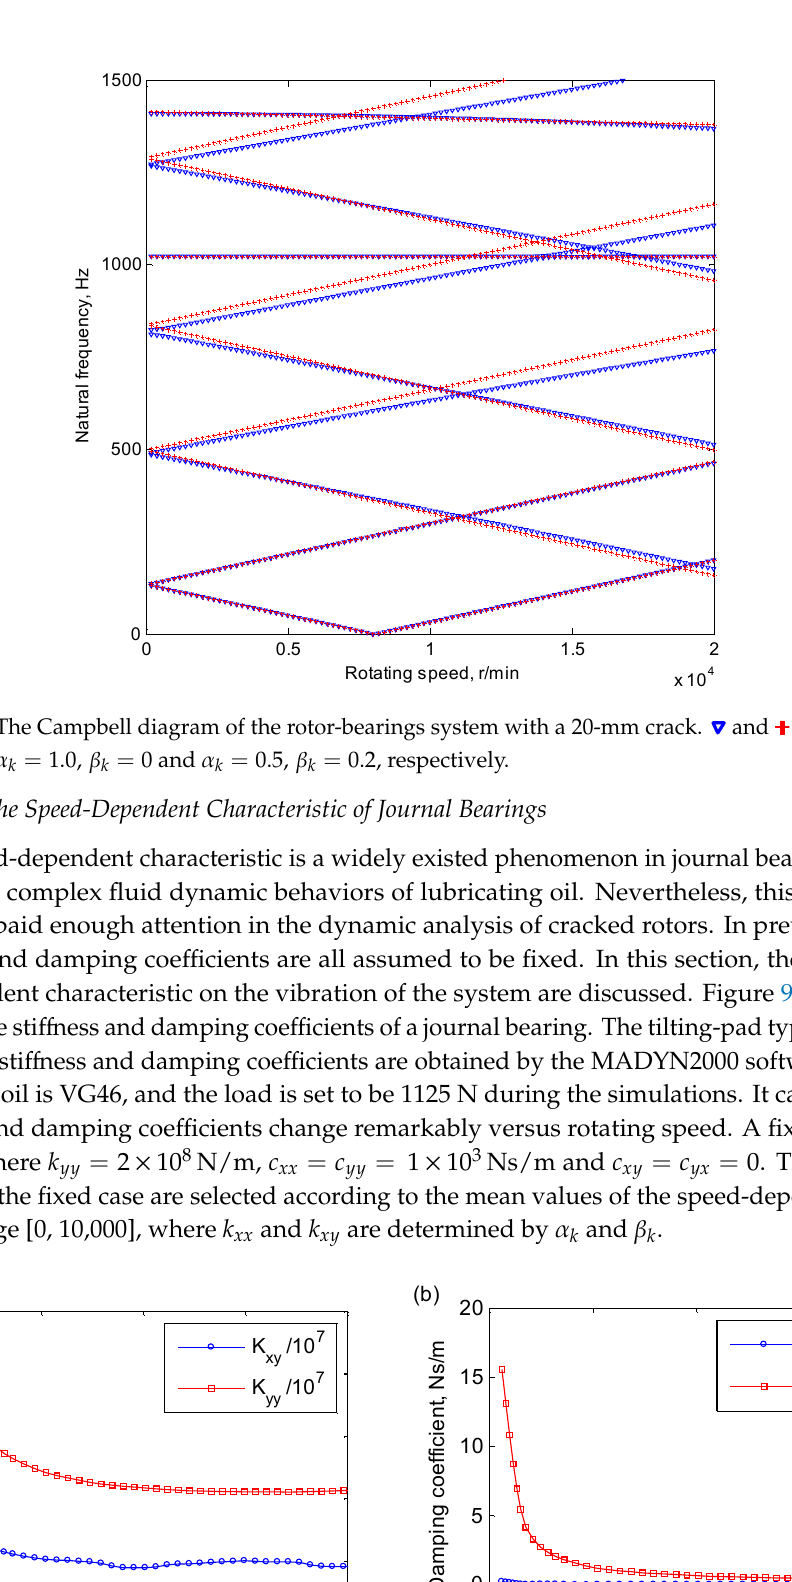
stiffness coefficient at the speed of 3800 r/min: ( a )